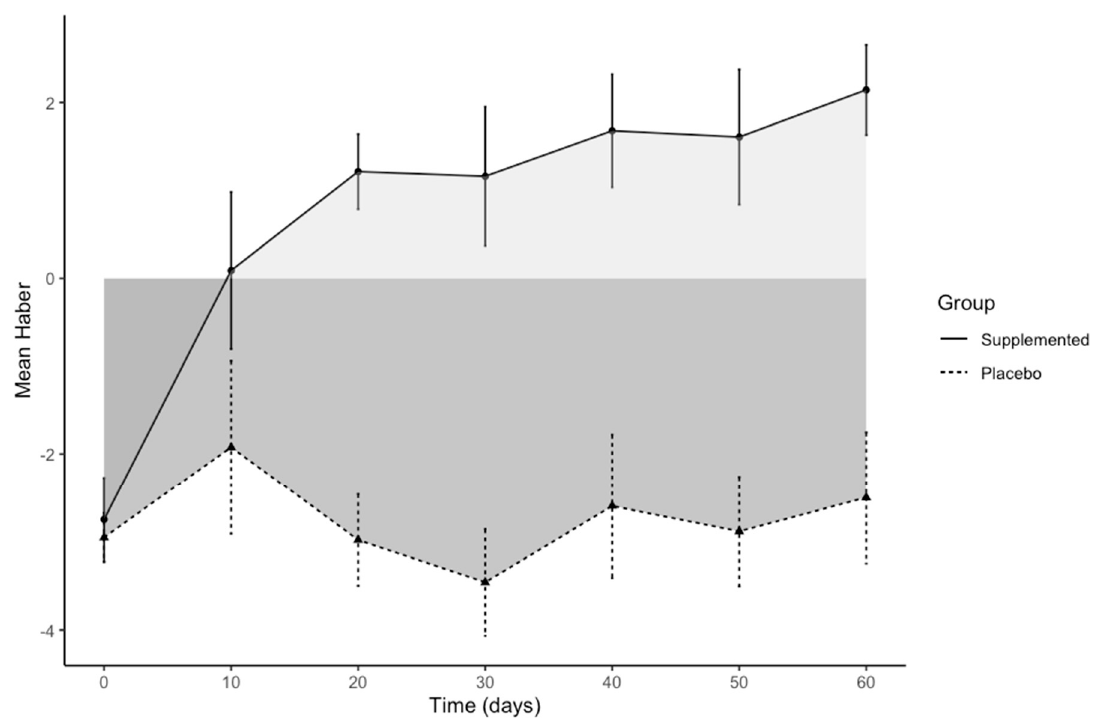
Figure 3. Plot of Haber’s mean scores for satiety against time, considering only the six intervals, shown separately per group. Error bars indicate the standard errors of the mean, while the gray shading indicates the area under the curve for the two groups.